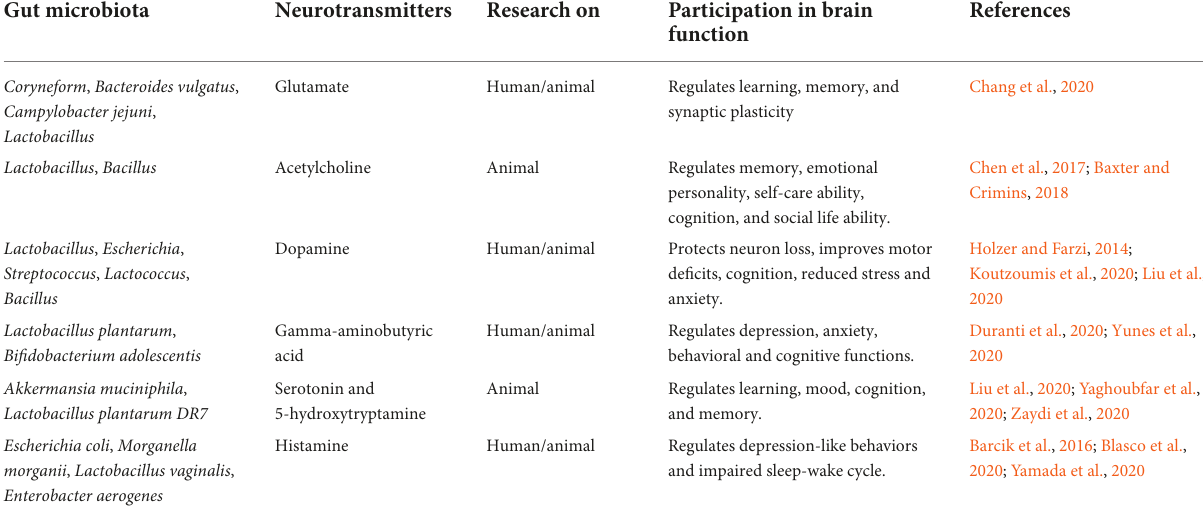
TABLE 1 Neurotransmitters (metabolites) made by the intestinal microbiota and their role in the functioning of the